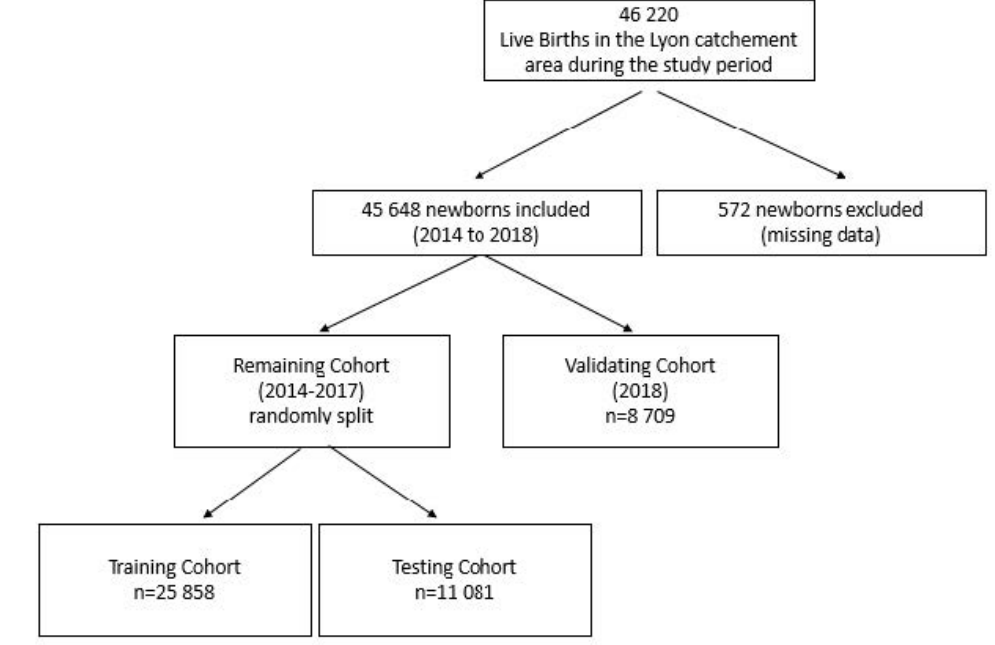
Figure 1. Flowchart of the study.